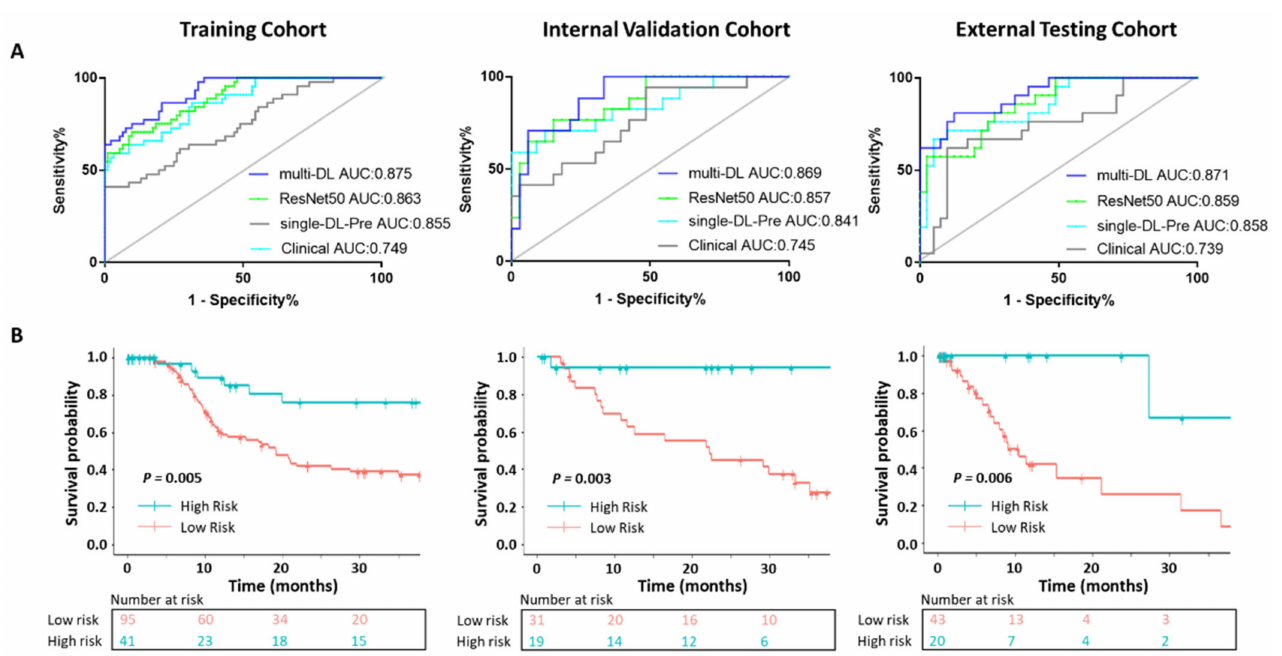
Figure 4. ROCs of OR prediction and risk stratification. ( A ) ROCs and AUCs of multi-DL, single-DL- Pre, ResNet50 and clinical model. ( B ) Survival curve of high- and low-risk patients stratified by the multi-DL